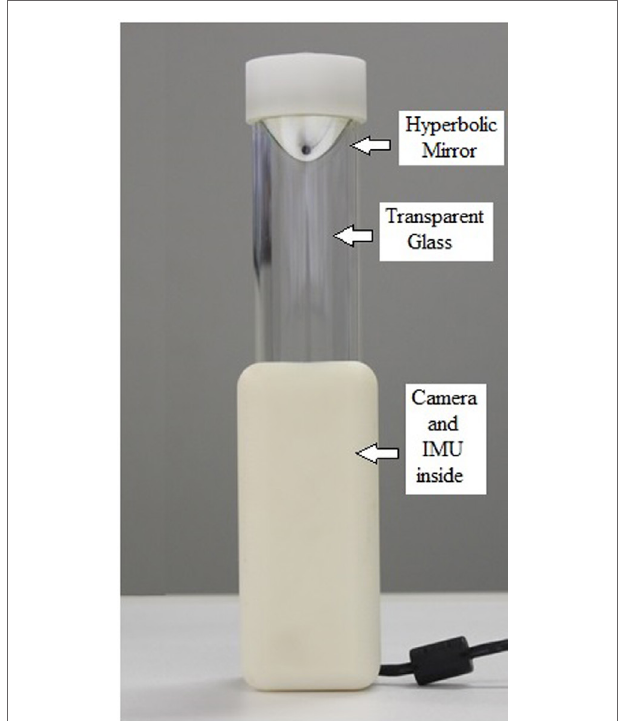
FIgURe 1 | gUlM Sensor overview: optical system and Inertial Measurement Unit (IMU)